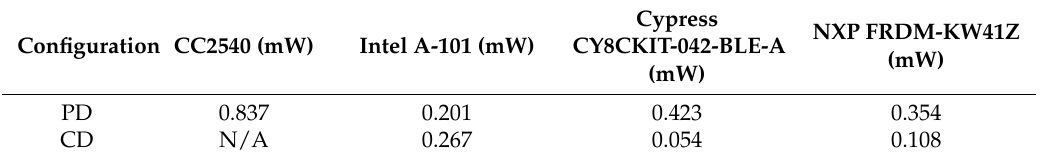
Table 4. Power consumption of the platforms configured as PD and CD using a connection interval of 100 ms and a 3V power supply.